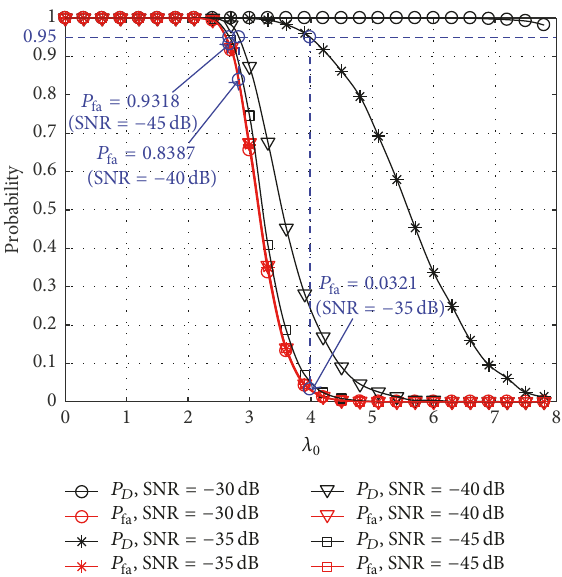
Figure 10: Detection and false alarm probability versus threshold factor 𝜆 0